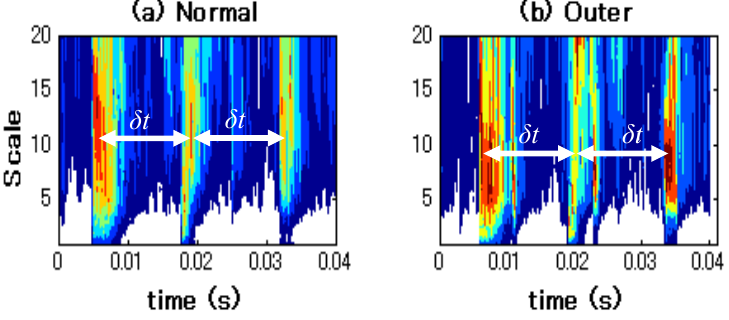
Figure 13. Contour graphs of CWT spectra by Daubechies wavelet. (a) Normal state. (b) Outer- race defect